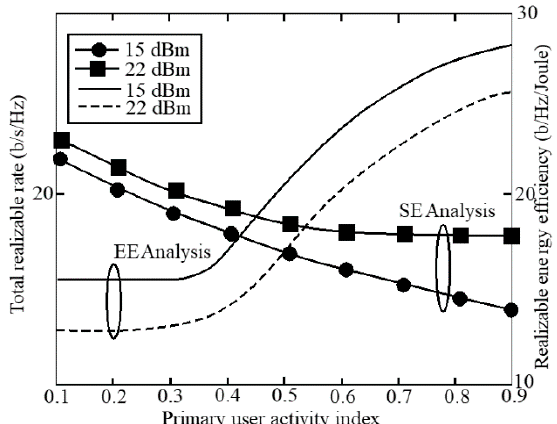
Figure 3. Total SE and EE analysis based on the PU activity index under different constraints of total power Z t.